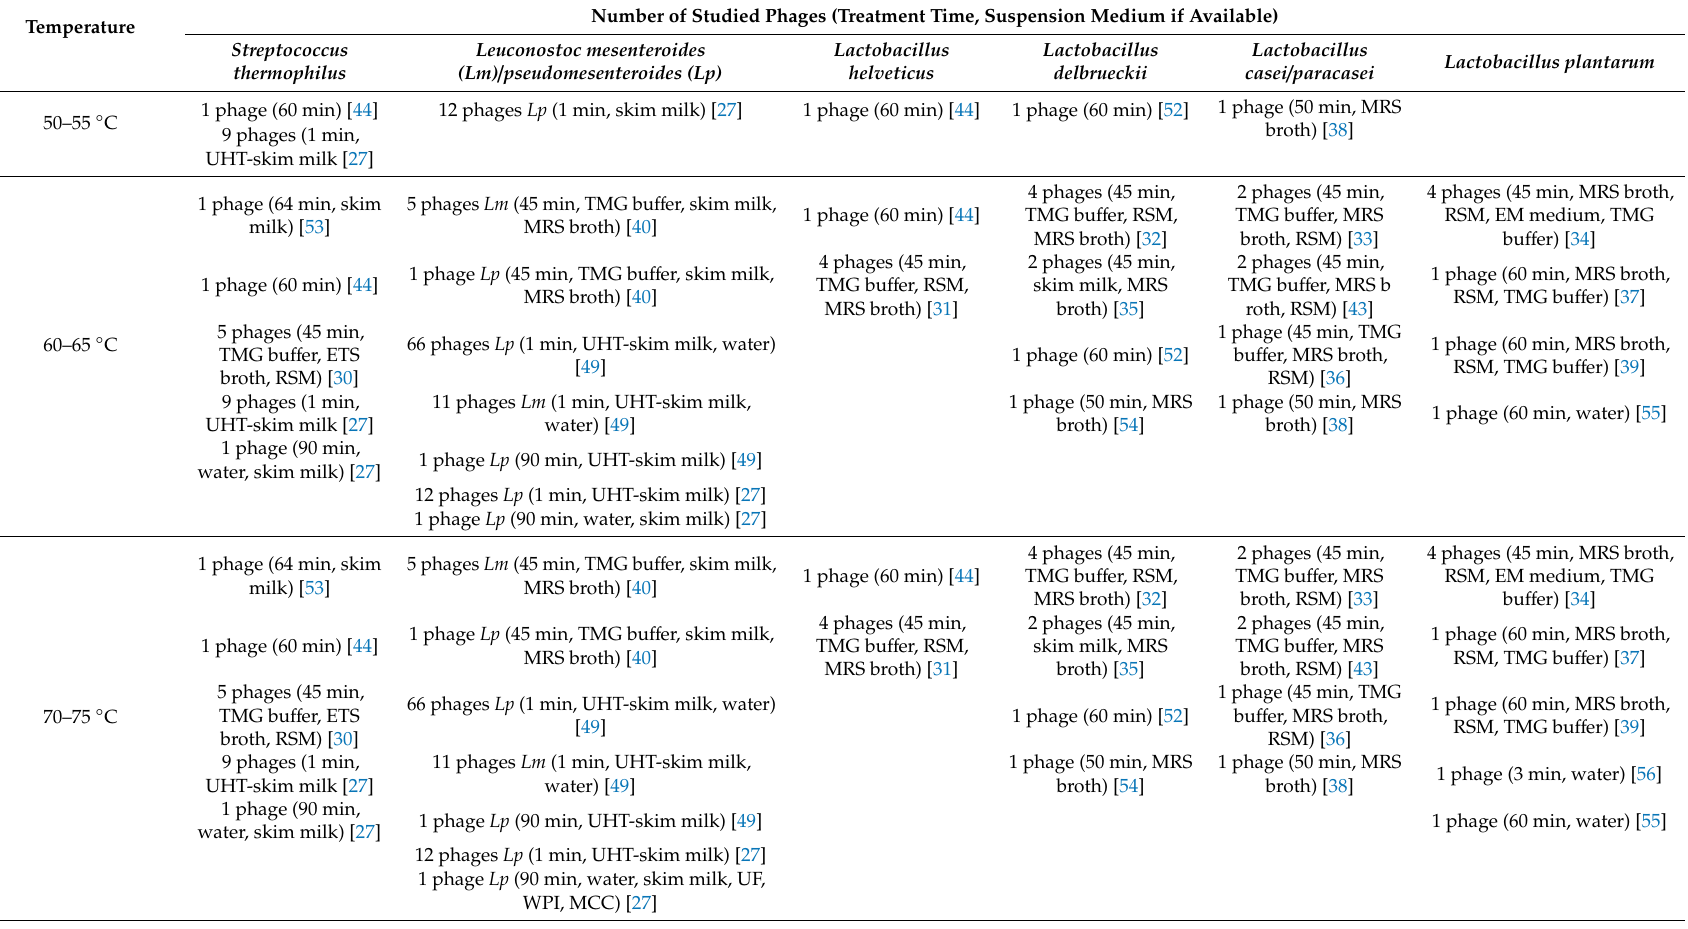
Table 4. Thermal treatments (temperature, time, suspension medium) studied for inactivation of dairy